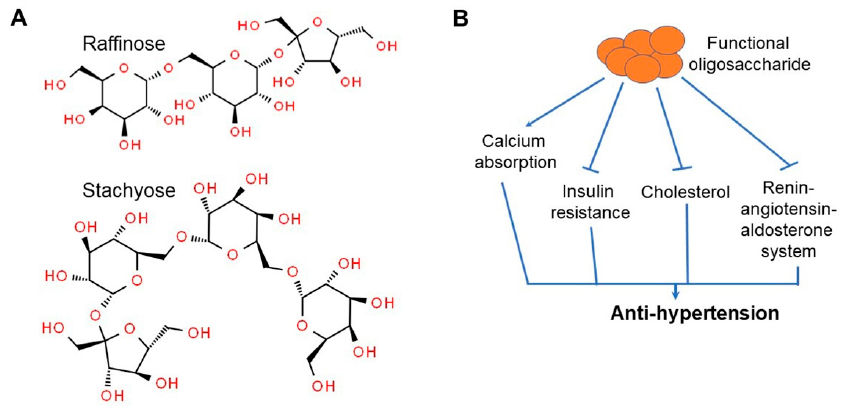
Figure 11. Chemical structures of soybean oligosaccharides comprising stachyose and raffinose ( A ) and effect of functional oligosaccharides on high blood pressure ( B ). Figure adapted from Zhu, D. et al.